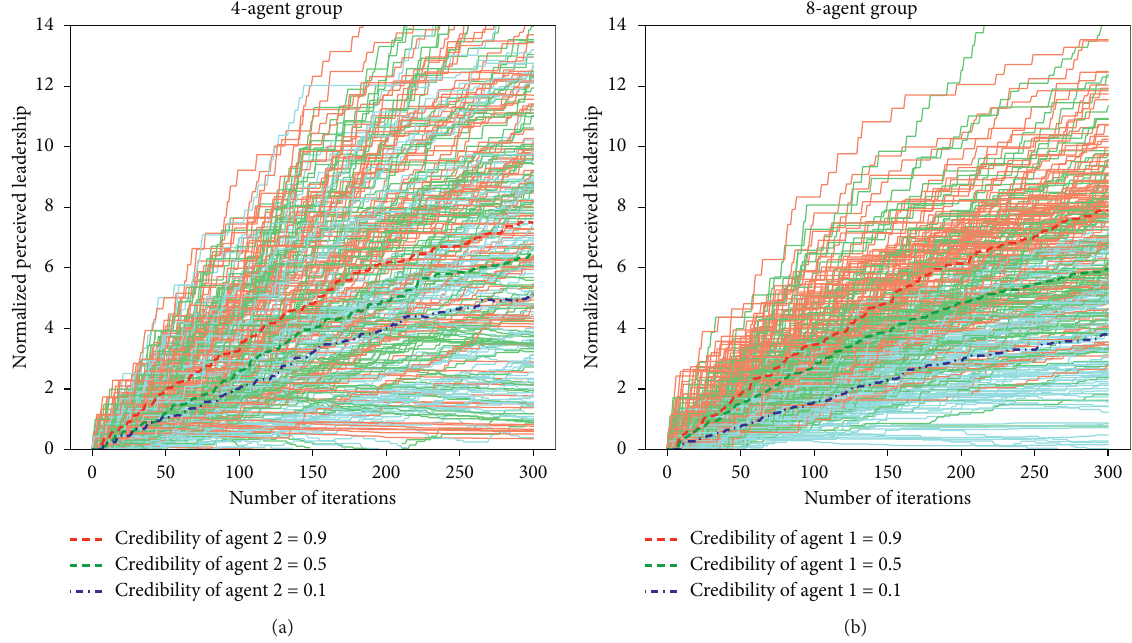
Figure 7: Perceived leadership of a certain agent (leader) with 3 levels of credibility in 4-agent group (a) and 8-agent group (b). The thin lines show the results of 100 independent simulation runs, while the thick dotted lines represent the median of those 100 runs. Note that agents’ other attributes are defined in Tables 1 and